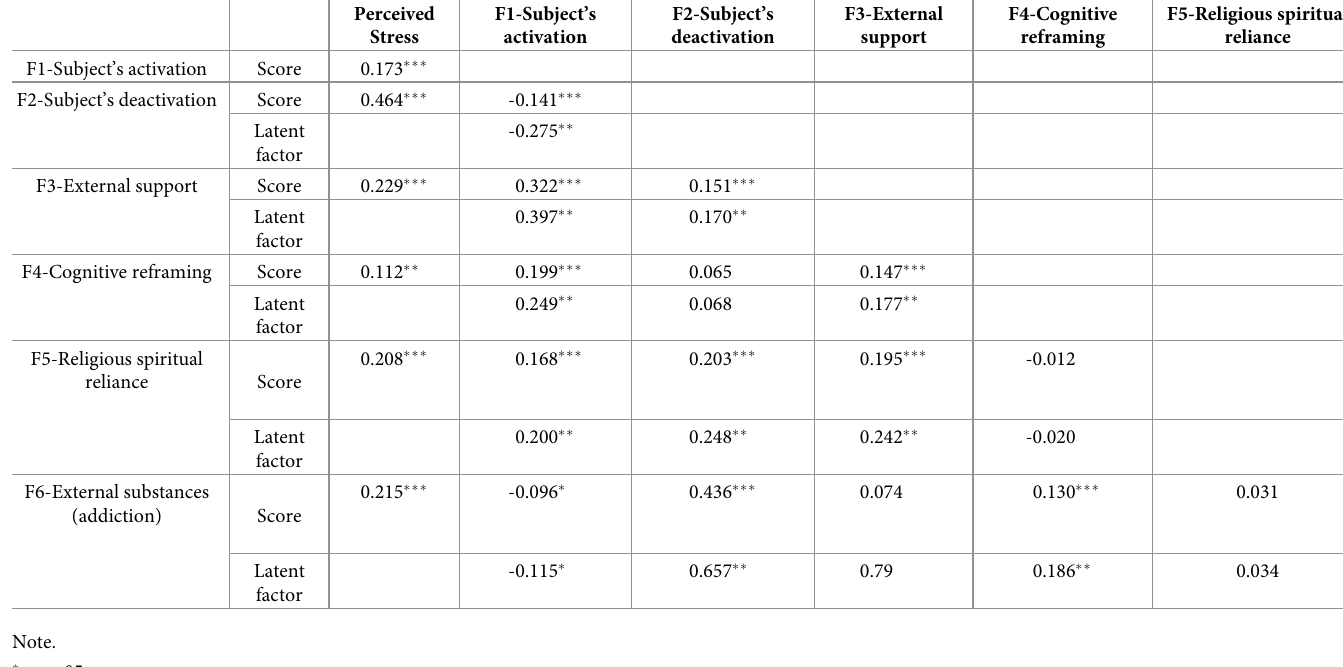
Table 3. Intercorrelations (Pearson’s r) between the six dimensions of the I-Brief COPE and the IPSS-10. For the six dimensions of the I-Brief COPE, intercorrela- tions between scores and latent factors are